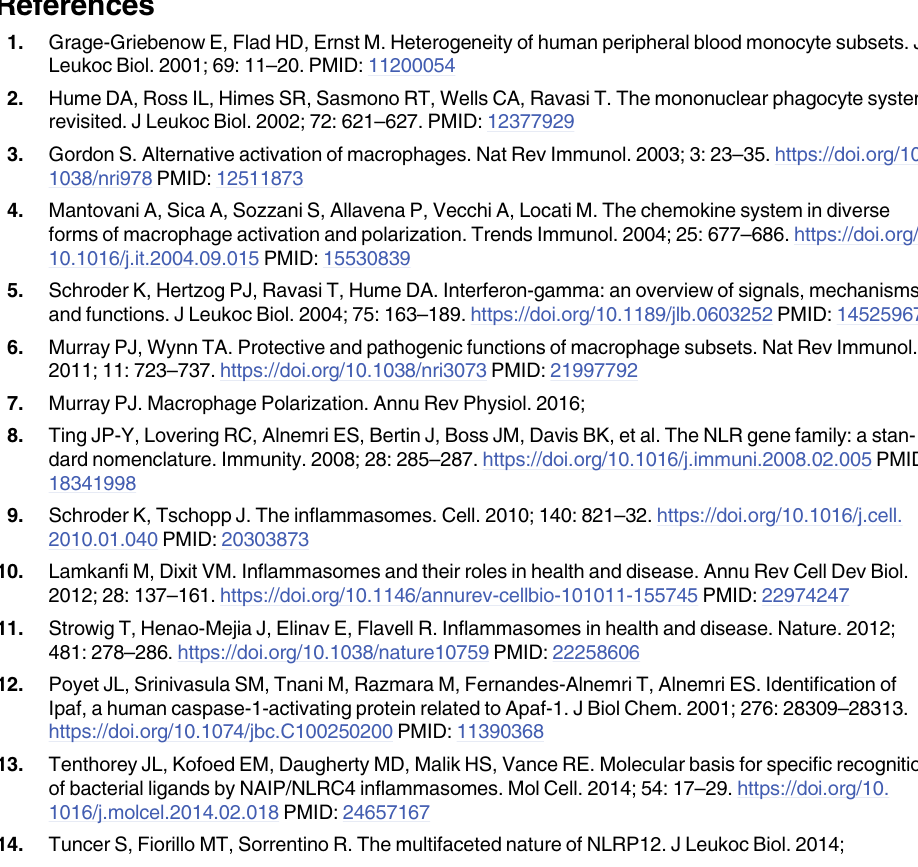
S1 Table. Primer sequences for